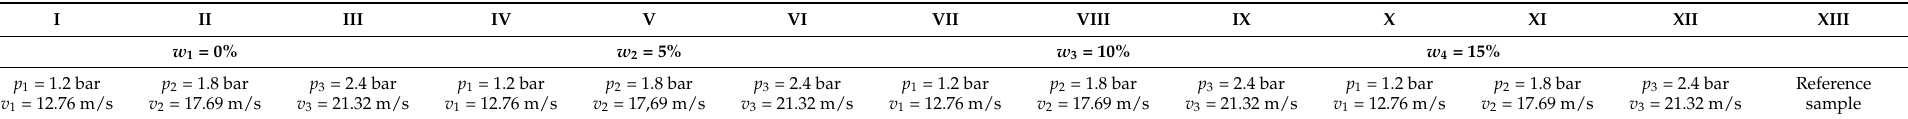
Table 4. Summary of silty sand sample variants used in particle size change